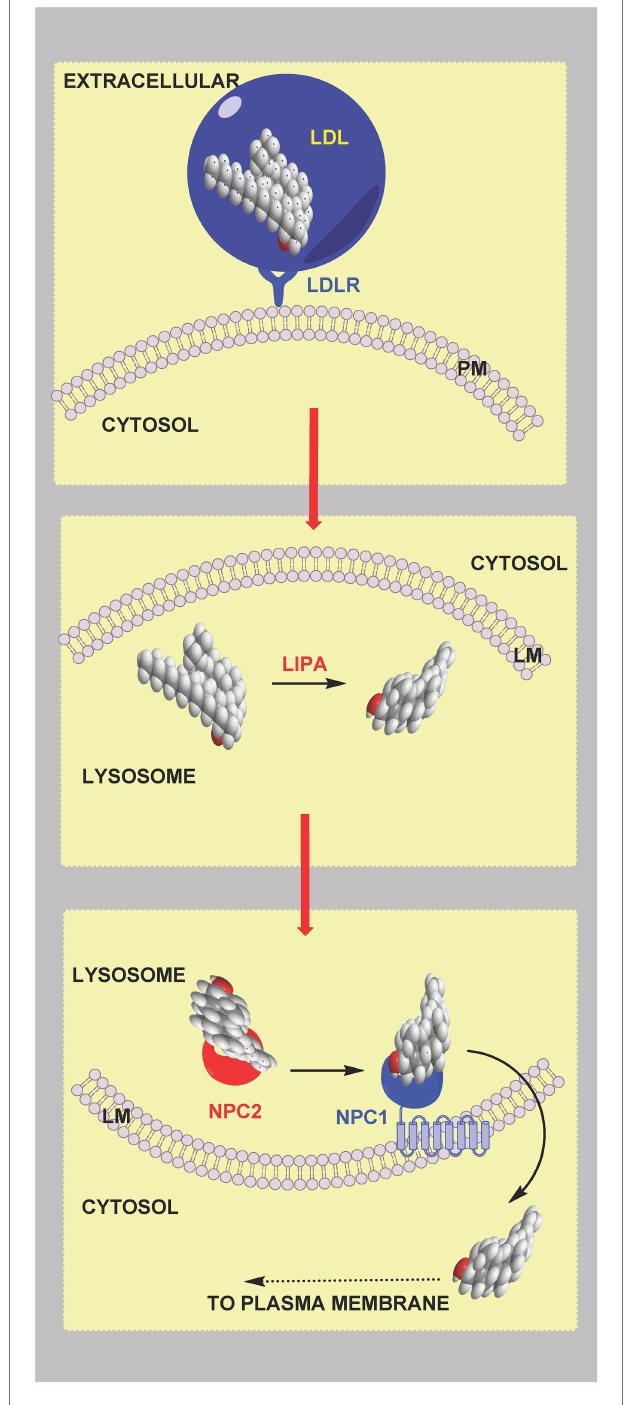
FIGURE 3 | Cartoon representation of cholesterol uptake and transport from the lysosome. LDL particles bind to the LDL-receptor (LDLR) on the extracellular surface of the plasma membrane and are taken up by receptor mediated endocytosis. Endosomes combine with the lysosome where cholesterol esters are hydrolysed by LIPA. Non-esterified cholesterols is transported by soluble NPC2 and membrane bound NPC1 to the lysosomal membrane for export. Exported cholesterol is thought to travel first to the plasma membrane before reaching the endoplasmic